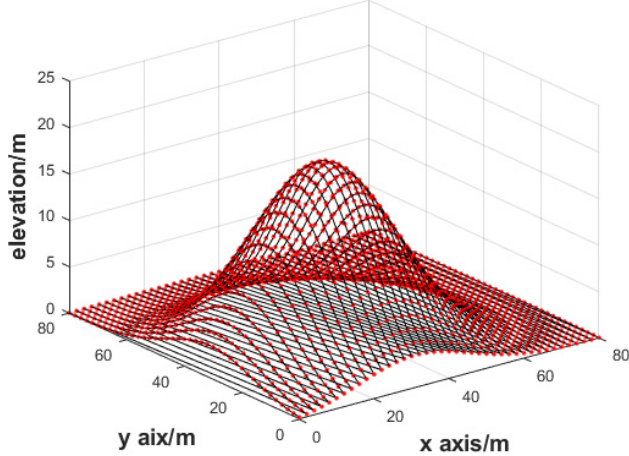
Figure 17. DTM by the RWLS method.